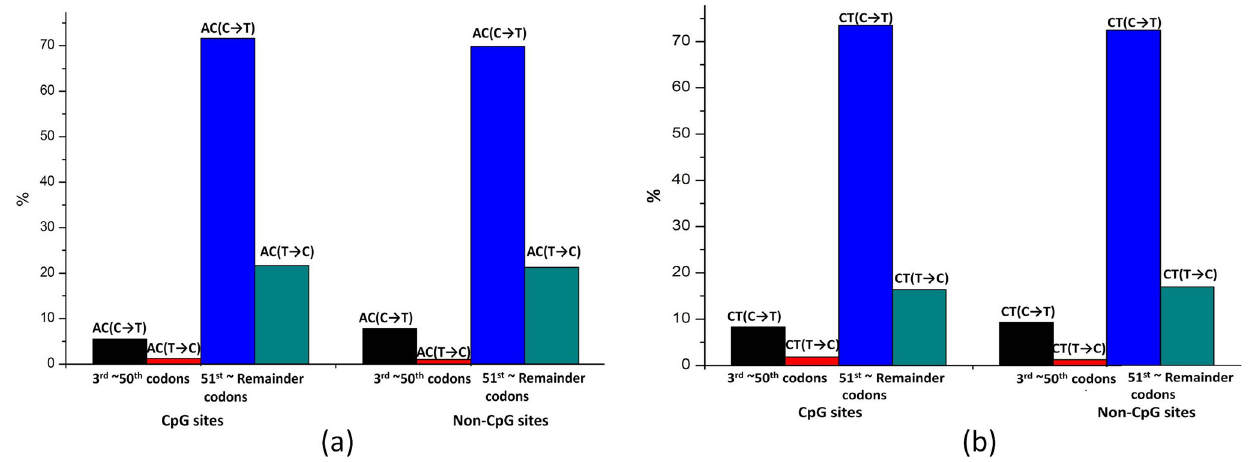
Figure 2. The distribution bias of (C R T) and (T R C) at non-CpG sites of the ramp regions. (a) The ratio of AC(C R T)/AC(T R C) at non-CpG sites of the ramp regions is larger than that at the reminder coding regions( P =0.006). (b) The ratio of CT(C R T)/CT(T R C) at non-CpG sites of the ramp regions is larger than that at the reminder coding regions ( P =0.029).